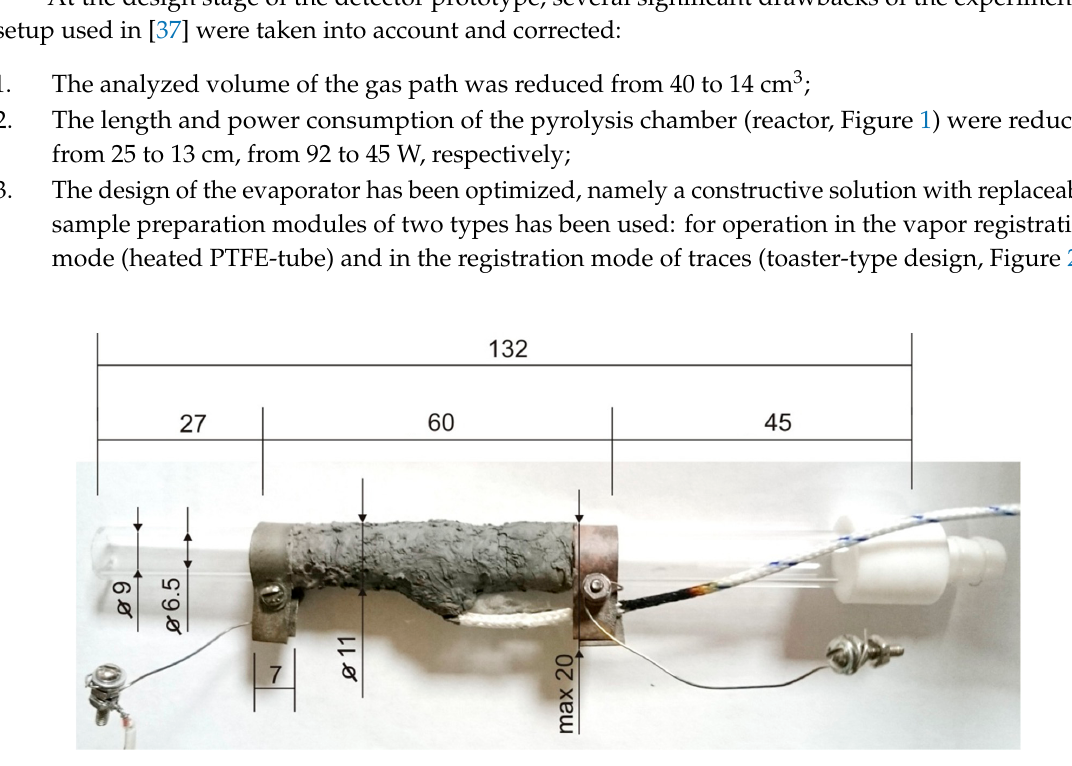
Figure 1. The pyrolysis chamber (reactor). Dimensions are given in mm.